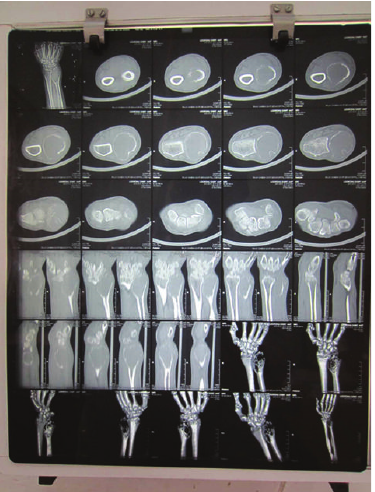
Figure 4: Preoperative computerised